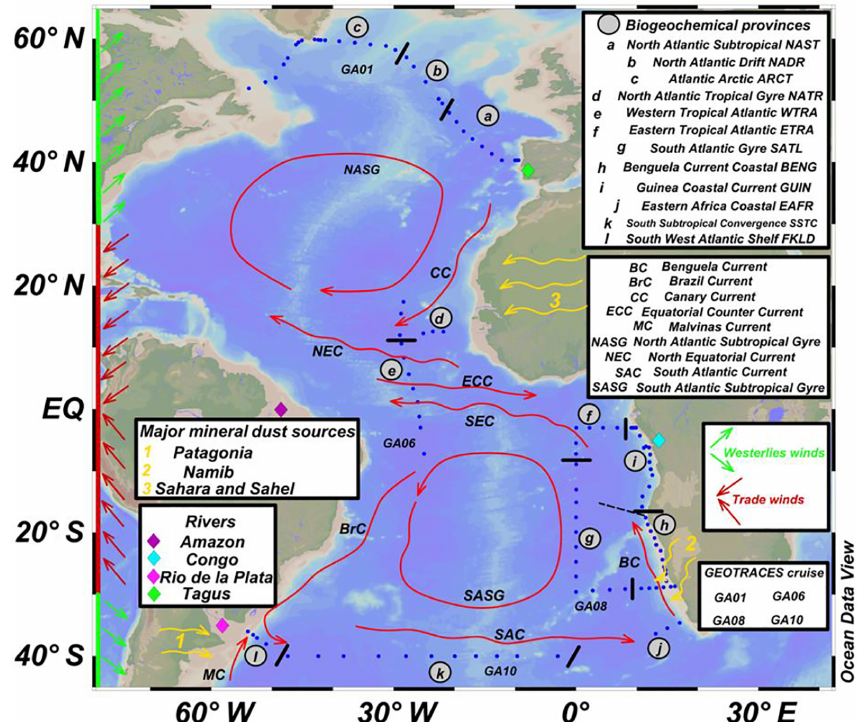
Figure 1. Map showing the location of the four GEOTRACES cruises. Red lines represent the main surface ocean currents. The diamonds represent rivers. Yellow arrows represent approximate areas which act as the main mineral dust sources to the Atlantic Ocean (Prospero et al., 2002). Black lines divide different biogeochemical provinces used in this study which are labelled with letters. Blue dots represent stations. For station numbers for each cruise please refer to Fig.